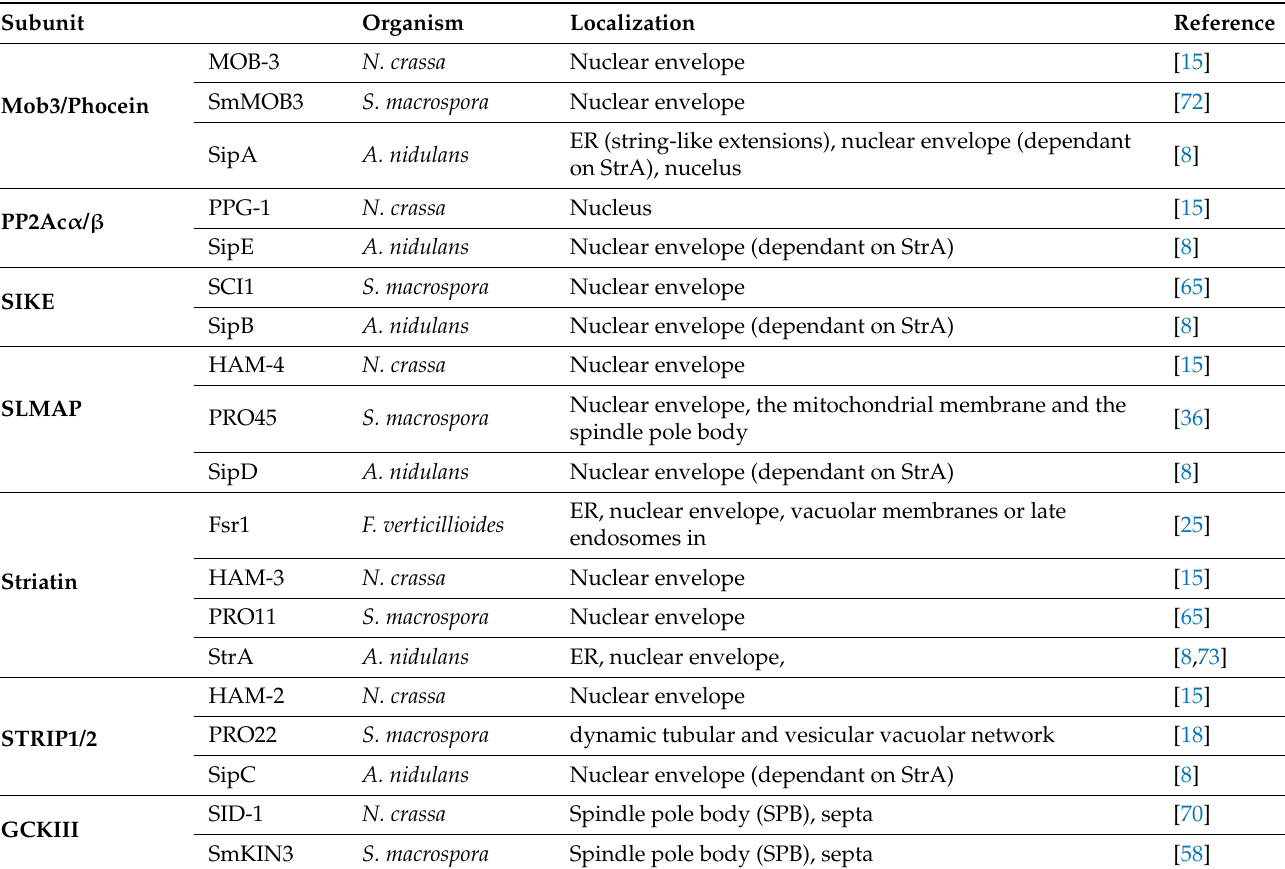
Table 2. Localization of STRIPAK subunits in various